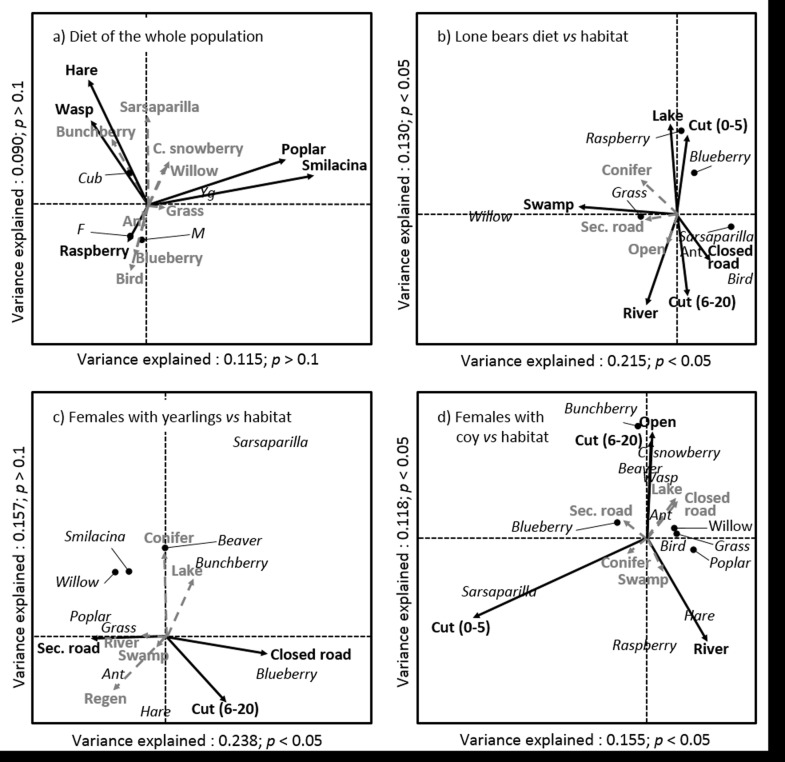
Graphical representations of Constrained Correspondence Analysis (CCA).Black arrows represent significant (p < 0.05) food item variables correlated with individual characteristics (in italics, panel a), and black arrows represent habitat variables correlated with the different food items (in italics, panel b,c d). Dashed grey arrows refer to variables that were not significantly correlated. In panel a (n = 28 feces of 6 different bears), body condition index and age are not shown to lighten the graphic and ease its interpretation as they were not significantly correlated with specific food items. Other panels represent relationships between habitat types and food items (in italics) by group of individuals sharing similar diets, as shown in panel a. Panel b for lone bears (n = 28 feces of 6 different bears), c for females with yearlings (n = 17 feces of 6 different bears) and d for females with cubs-of-the-year (n = 26 of 6 different bears).